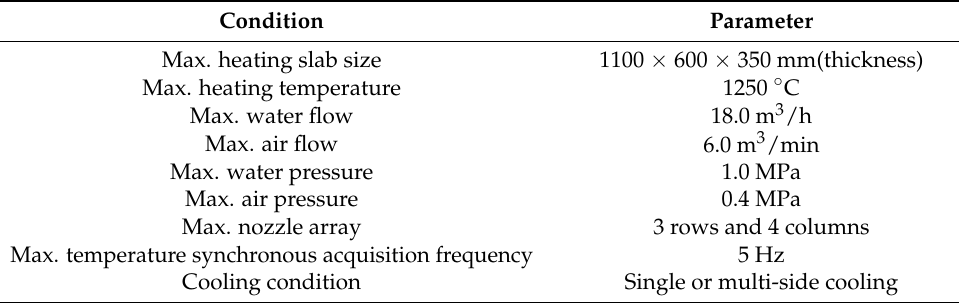
Table 1. Technical parameters of the pilot experimental set-up.